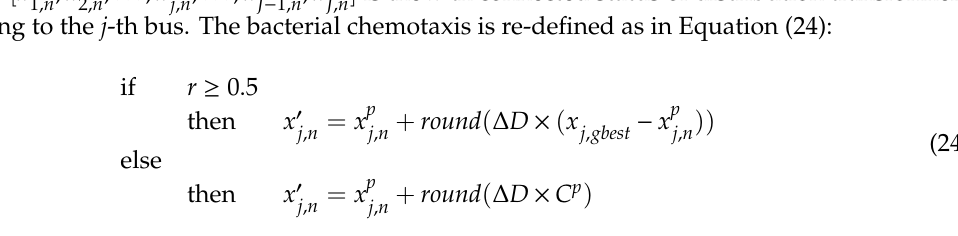
Figure 2 is the flowchart of IBFO